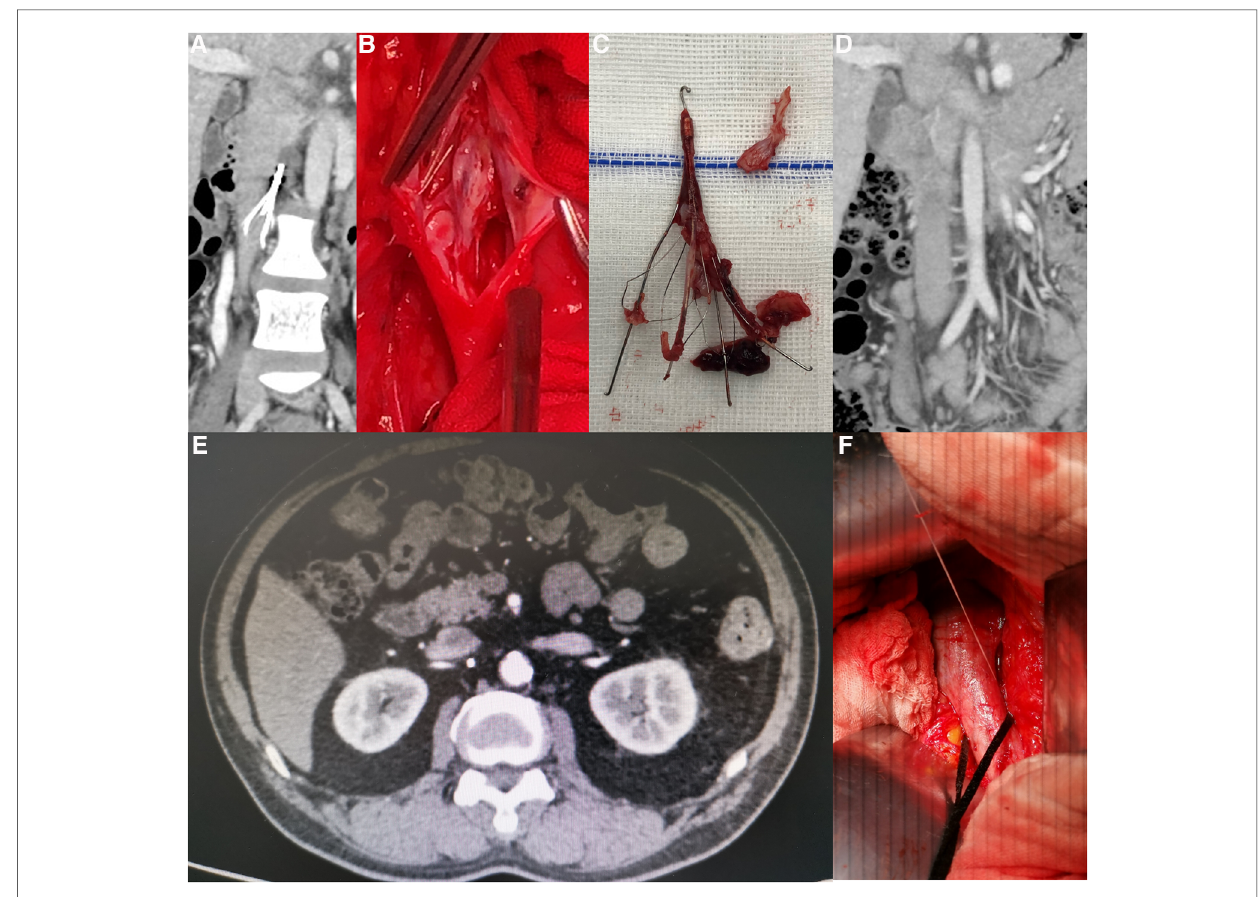
FIGURE 3 ( A ) Retention of Tulip fi lter for 16 months. ( B ) Tulip fi lter with obvious endothelial hyperplasia and failed endovenous removal. ( C ) Complete removal of Tulip fi lter with severe endothelial hyperplasia. ( D ) Follow-up of Tulip fi lter removal at 6 months after surgery with patent IVC. ( E ) CT image of the Celect fi lter showing the retrievable hook penetrating the IVC. ( F ) Intraoperative retrievable hook penetrating the venous wall with a preplaced purse-string suture.